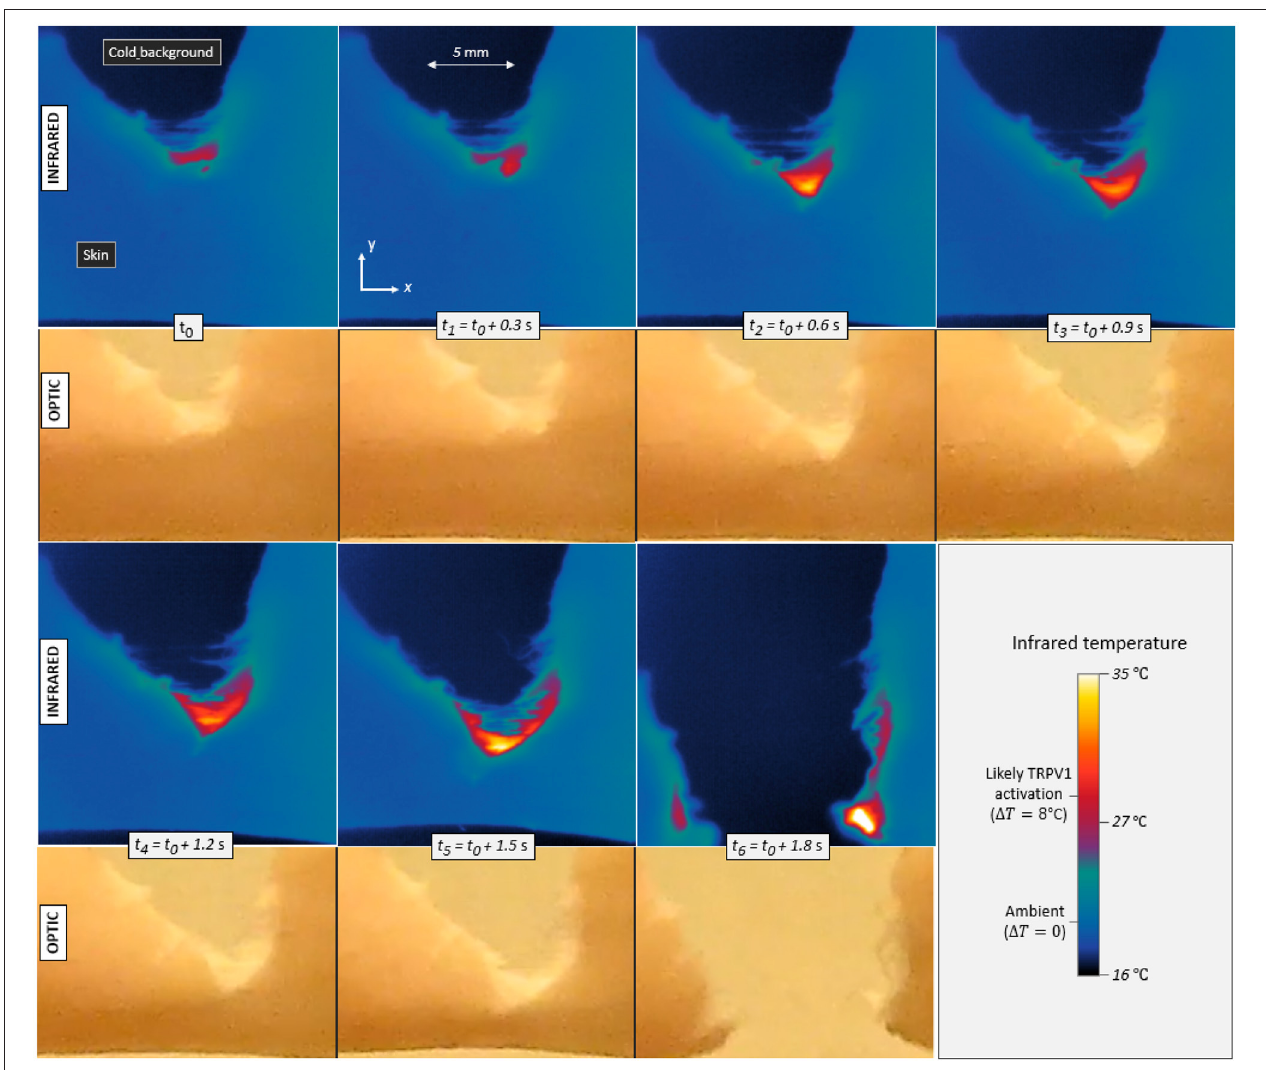
FIGURE 3 | Infrared temperature maps and corresponding optical frames during the propagation of a tensile crack in porcine skin (skin specimen V). Seven different times are displayed with a constant increment in between. The maximum temperature elevation is 1 T ( t 6 ), Contrarily to the infrared camera, the optical camera monitored the whole set-up and was not equipped with a macroscopic lens, hence the noticeable difference in image resolution. It also recorded the skin with a slightly different (non-orthogonal) line of sight, as per Figure 1